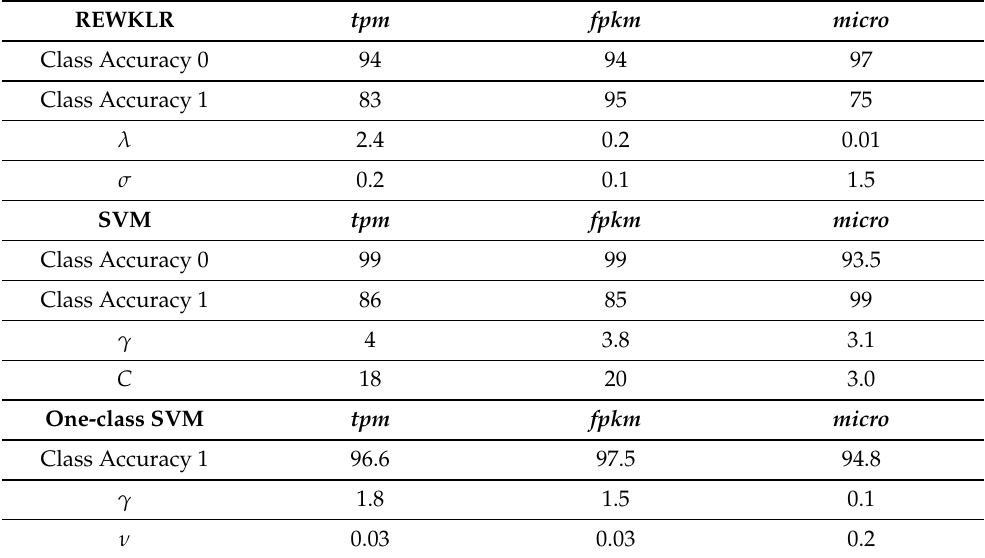
Table 1. The optimal training parameters and class accuracy for all classification models in the order (REWKLR, SVM, and one-class